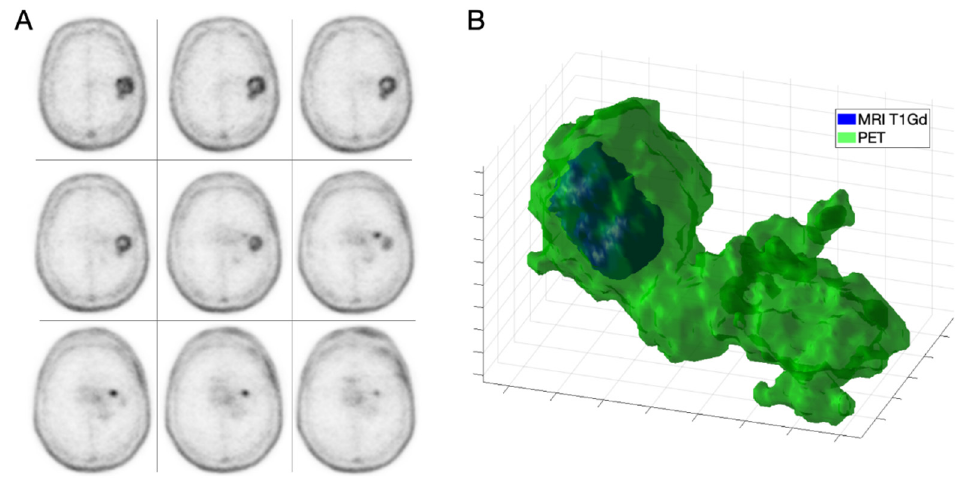
Figure 1. IDH-wt high grade GBM in a 68-year-old male (patient 1). Axial slices of 18 F-fluorocholine PET ( A ) and combined three-dimensional representation of segmented tumor on MRI T1-Gd and PET ( B ) with total volumes of 3.97 and 36.45 mL, respectively.